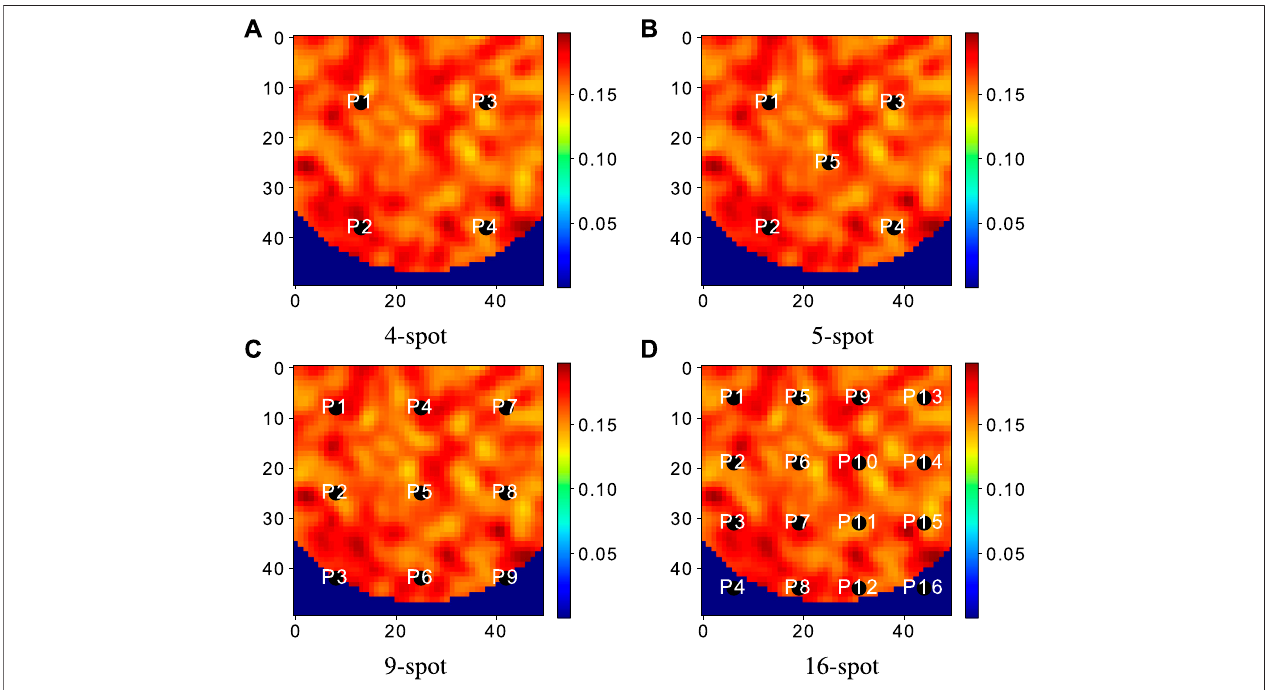
FIGURE 7 | Illustration of the 4-, 5-, 9- and 16-spot well pattern with the background as the porosity fi eld of a speci fi c test scenario.